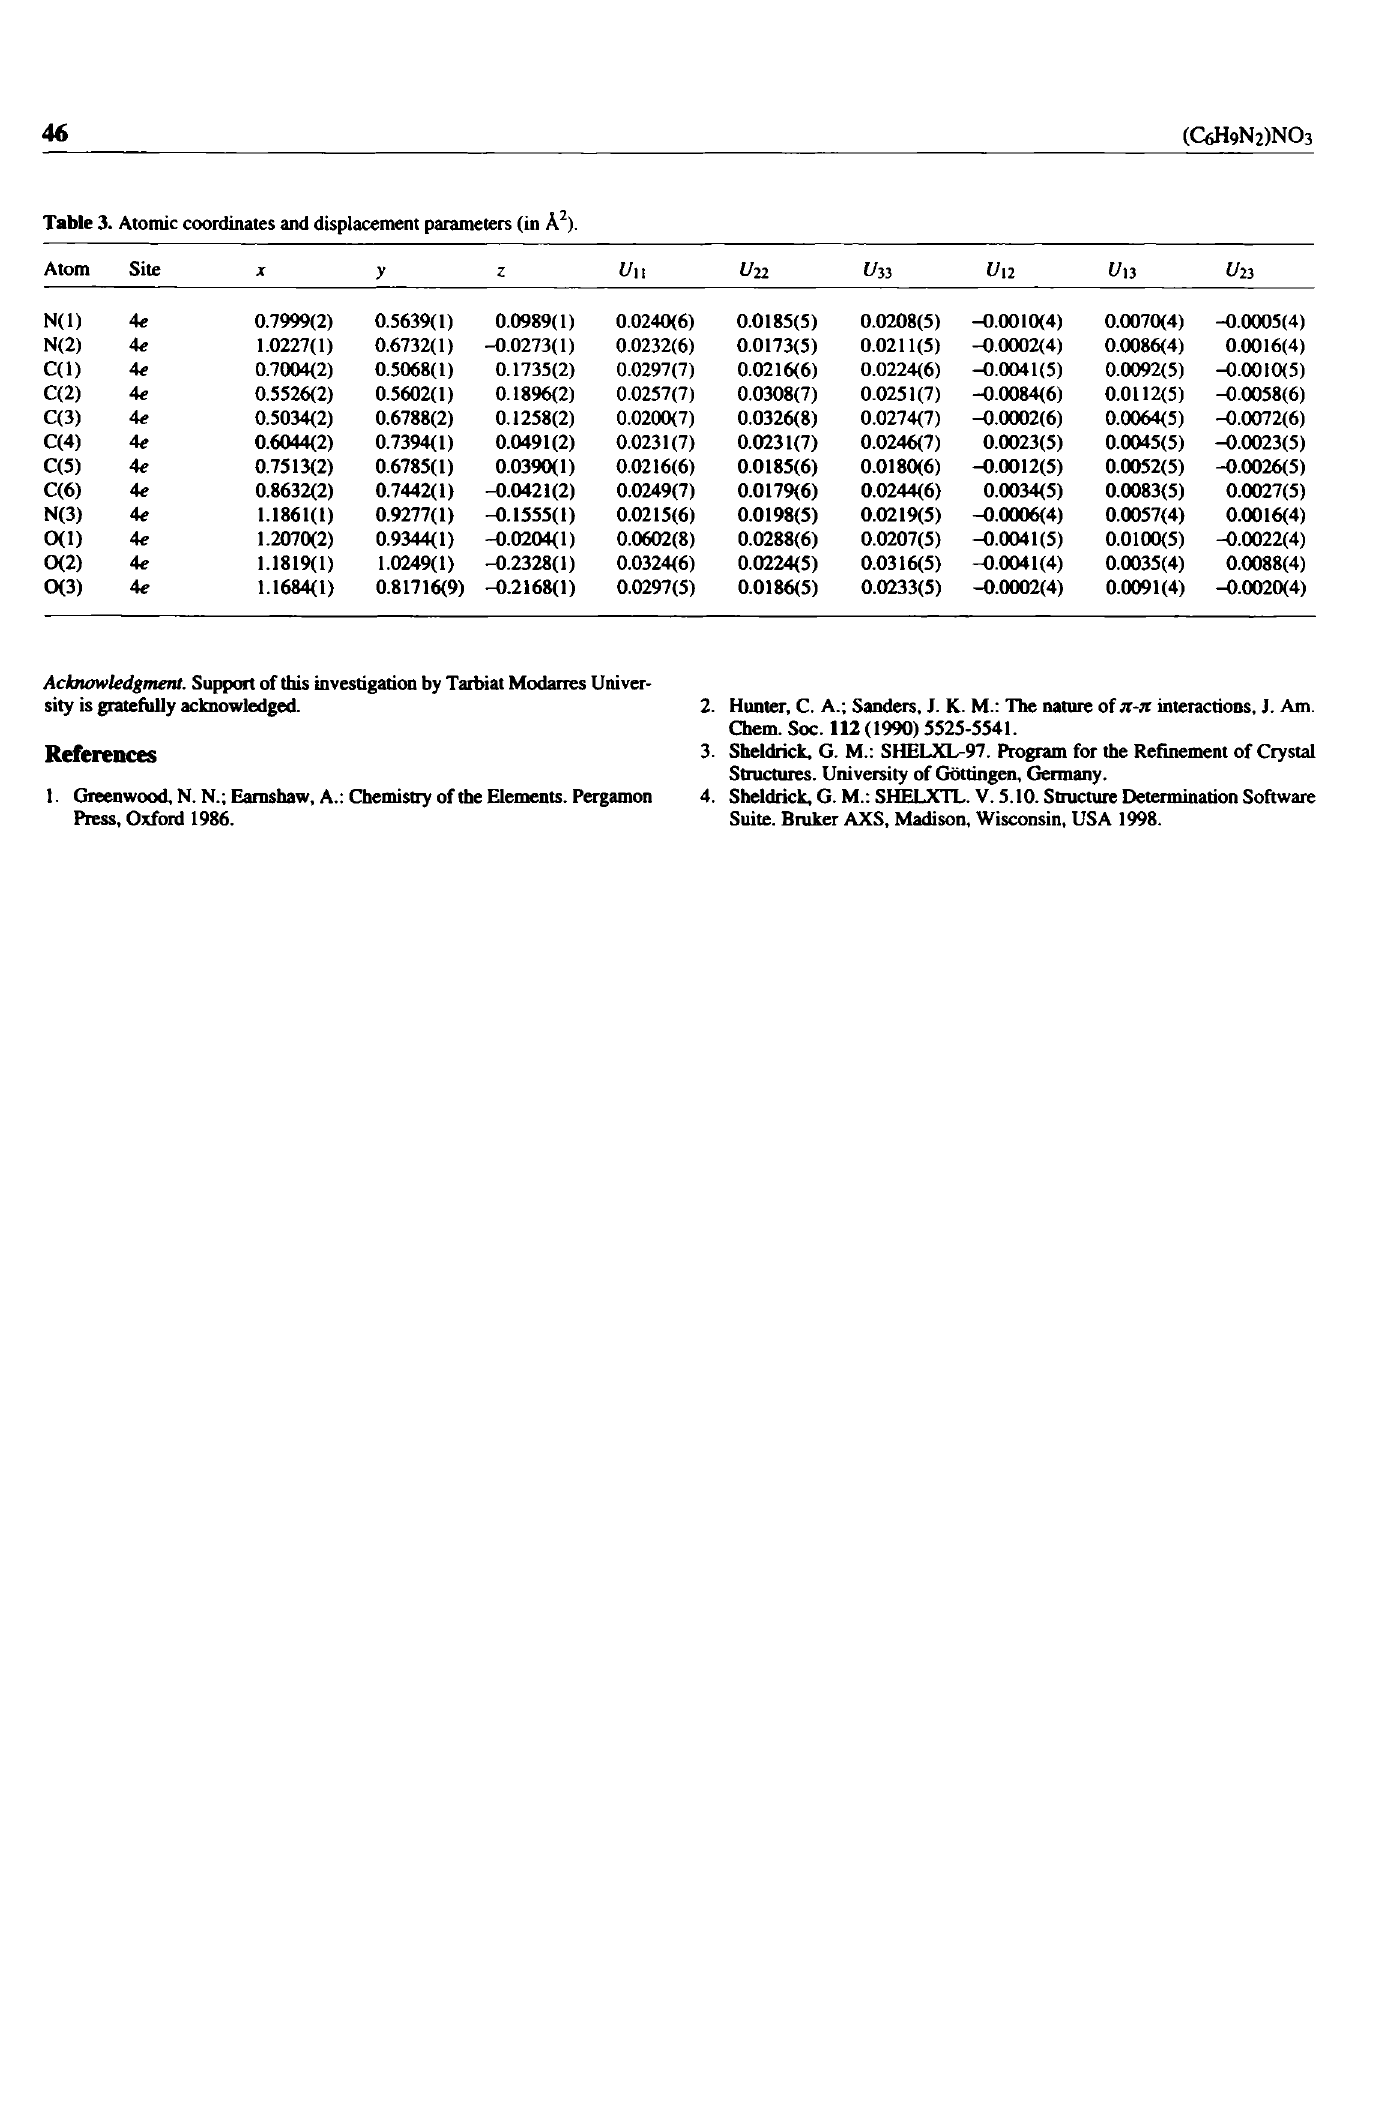
Table 3. Atomic coordinates and displacement parameters (in Ä 2